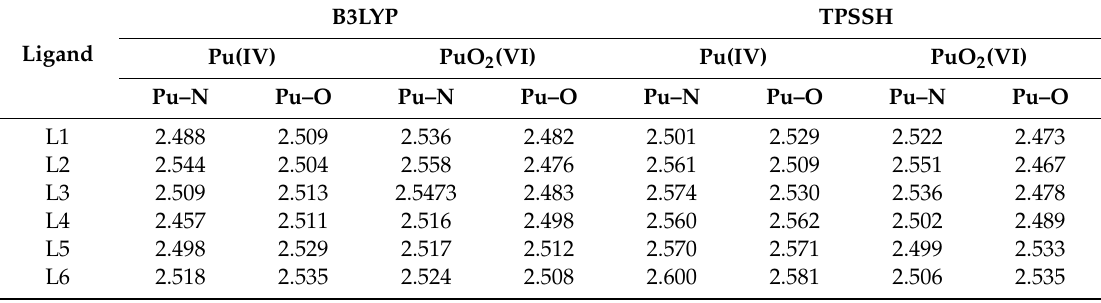
Table 1. Average bond length (Å) of Pu–tridentate structures. Each number shows the distance between Pu and N or O in the optimized structure.